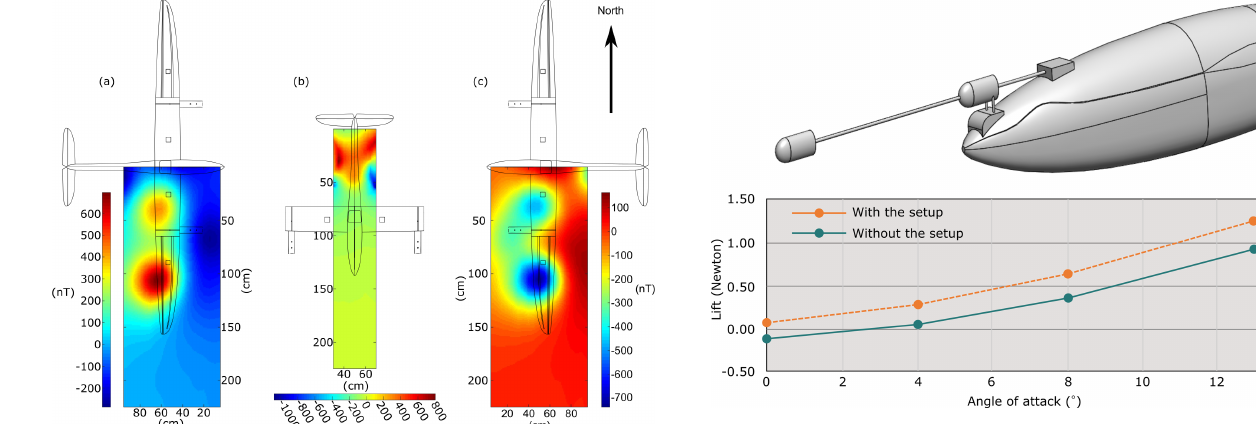
Figure 5. The nose-mounting solution and its aerodynamic